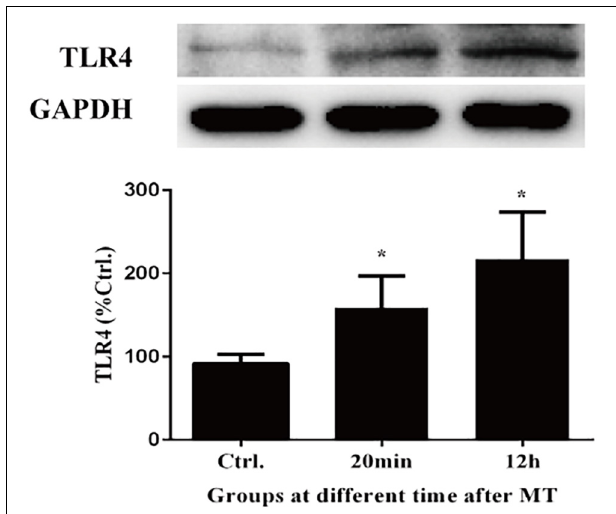
FIGURE 11 | The changes of TLR4 in cecal tissue. There were statistically increased at 20 min and 12 h after MT (* P < 0.05 vs. the